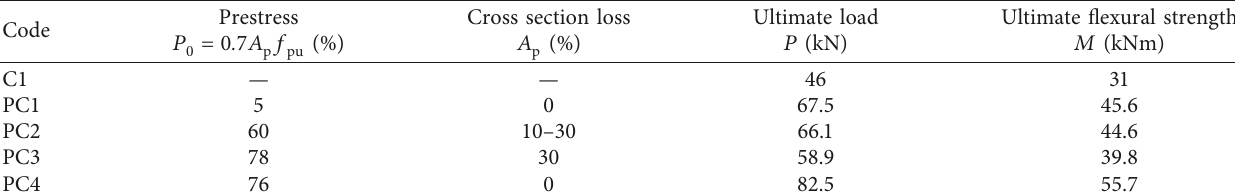
Table 4: Data of specimens tested by Youn and Kim